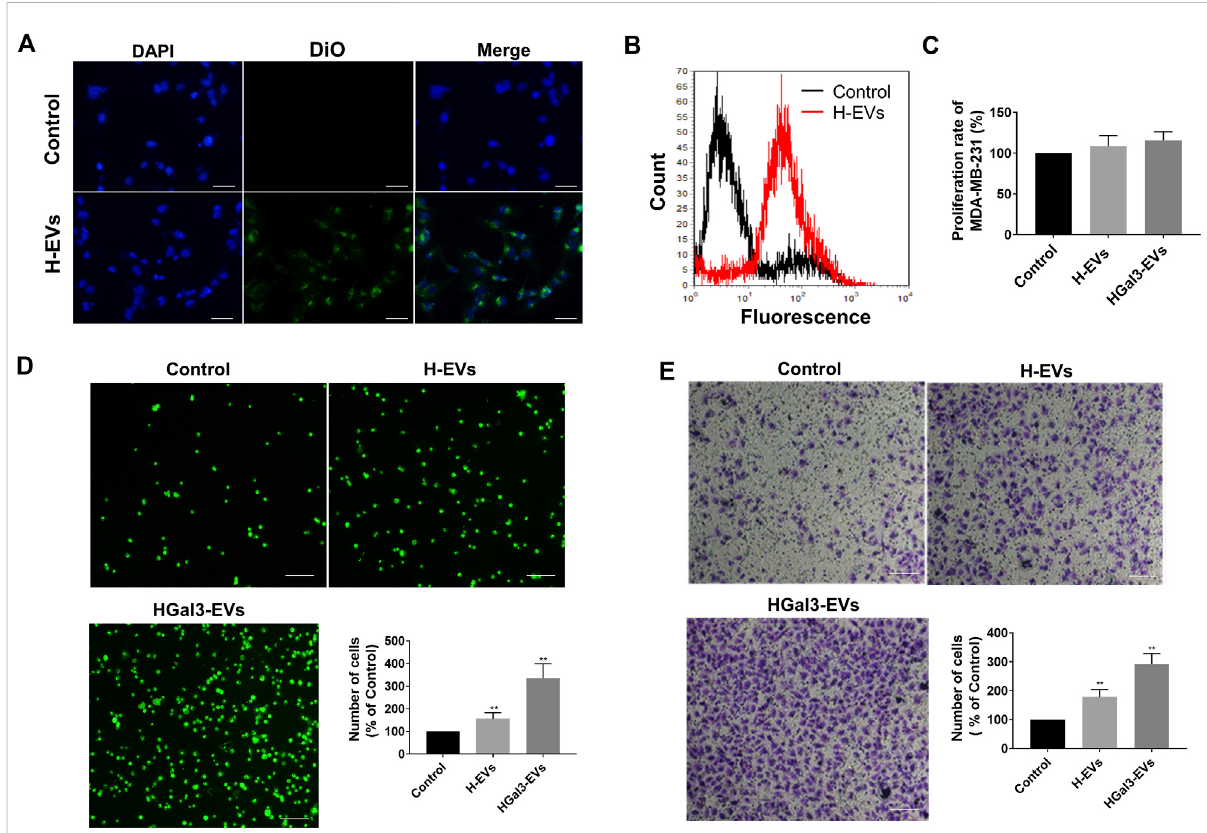
FIGURE 2 Gal-3 treatedHUVECsderivedH-EVs enteredMDA-MB-231cellsto promotemigrationand celladhesiontoHUVECs. (A) Fluorescent imageof the internalization of Dio-labeled H-EVs in MDA-MB-231 cells (magni fi cation, ×200, bar = 200 μ m). (B) The internalization of Dio-labeled was detected by fl ow cytometry experiment. (C) The effect of H-EVs on the proliferation of MDA-MB-231 cells was detected by CCK-8. Control: PBS; H-EVs: EVs from HUVECs; HGal3-EVs: EVs from HUVECs treated with 1 ng/ml Gal-3 for 24 h. (D) The effect ofH-EVs on theadhesionof MDA- MB-231 cells to HUVECswasdetected byadhesionassay (magni fi cation, ×100,bar = 100 μ m). (E) The effect of H-EVson themigrationof